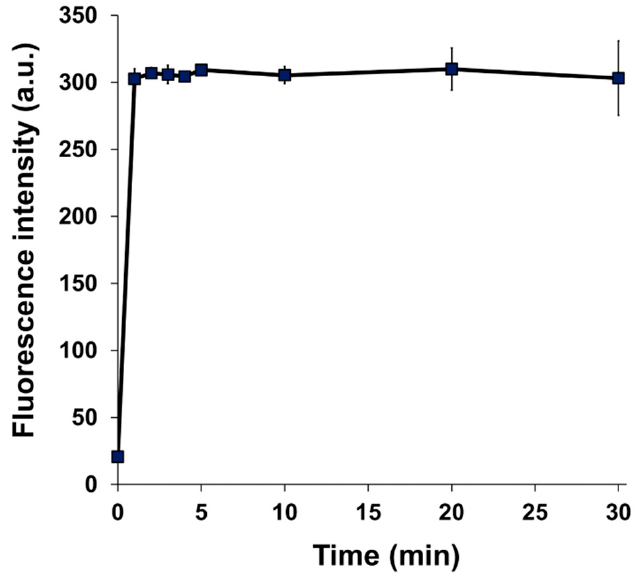
Figure 3. Temporal change in fluorescence intensity after mixing of BITQ (1.0 µ M) and BPA (100 µ M) in 0.5% DMSO/H 2 O ( λ ex = 390 nm, λ em = 480 nm).